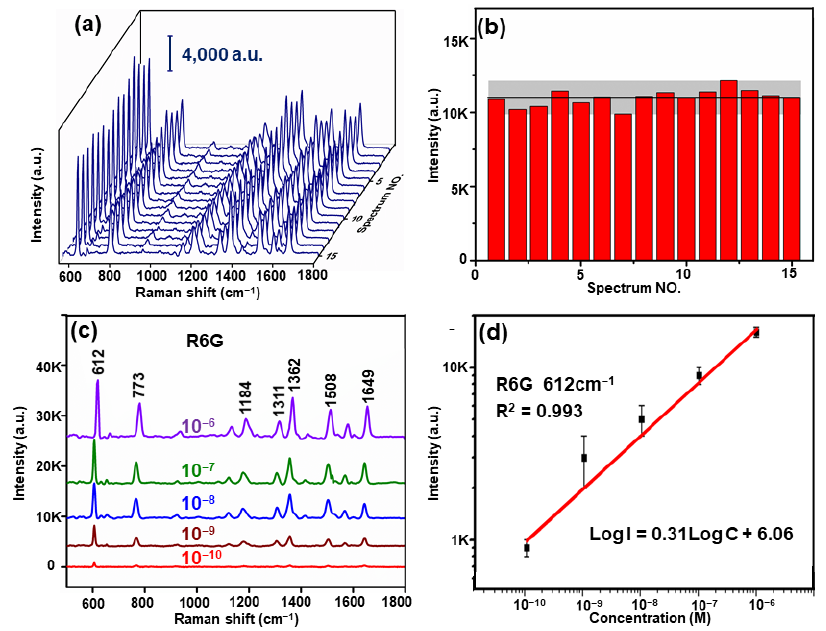
Figure 6. ( a ). The Raman signal of the 10 −6 M R6G collected randomly from 15 spots in 15 compo- site substrates with six Au/Al 2 O 3 bilayers. ( b ) The intensity of 612 cm −1 peak for the composite substrates with six Au/Al 2 O 3 bilayers. ( b ) The intensity of 612 cm − 1 peak for the composite struc- structures. ( c ) The SERS spectra of R6G at concentrations ranging from 10 −6 to 10 −10 M. ( d ) The cali- tures. ( c ) The SERS spectra of R6G at concentrations ranging from 10 − 6 to 10 − 10 M. ( d ) The calibration bration curve of the normalized Raman intensity at 612 cm −1 versus R6G of different concentra- curve of the normalized Raman intensity at 612 cm − 1 versus R6G of different tions.